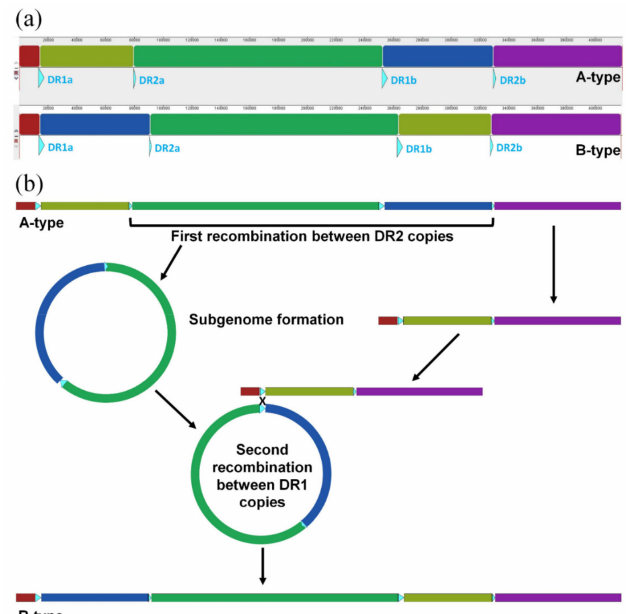
Figure 6. Two alternative mitochondrial genome structures in Damnacanthus indicus ( a ) and a plausible molecular scenario of genome rearrangement ( b ). Direct repeats are presented as the sky-blue triangles and their size is larger than their actual size (DR1 = 3500 bp, DR2 = 61 bp). Locally colinear blocks (LCBs) of Mauve alignment are presented as five bars of different colors. The red and purple LCBs are separated in linearized genomes; however, these are a single-connected sequence block in circular form. In scenario ( b ), the A-type is treated as an ancestral type since it is shared by the majority of individuals (five) (Table 5). The first and intramolecular recombination between DR2a and DR2b can generate two smaller subgenomic molecules. Subsequently, the second and intermolecular recombination between DR1a and DR1b can mediate the re-integration of one genomic molecule into the other. Ultimately, the new genome formation (B-type) can be